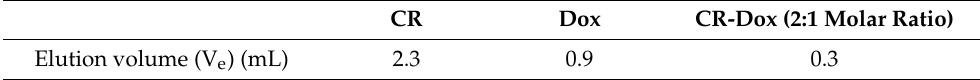
Table 1. Elution volume for CR, Dox, and CR-Dox